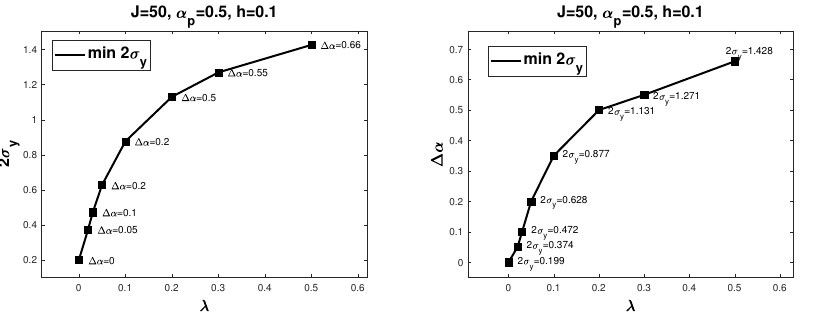
Figure 8. High performance control (minimal output variance—reflected by 2 σ y ) against correspond- ing λ for various ∆ α values ( left ), and the ∆ α as a function of λ penalty